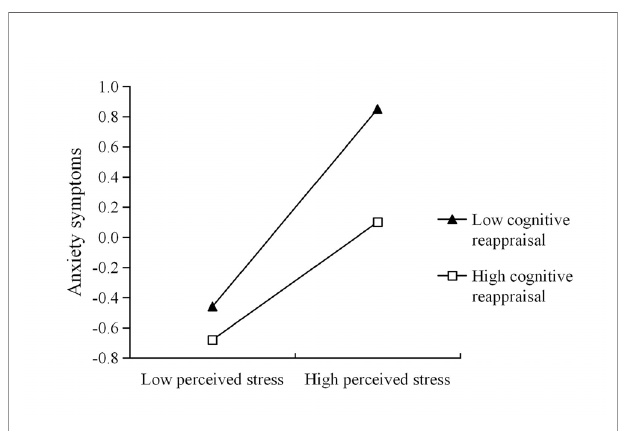
FIGURE 1 | Cognitive reappraisal moderates the relation between perceived stress and anxiety